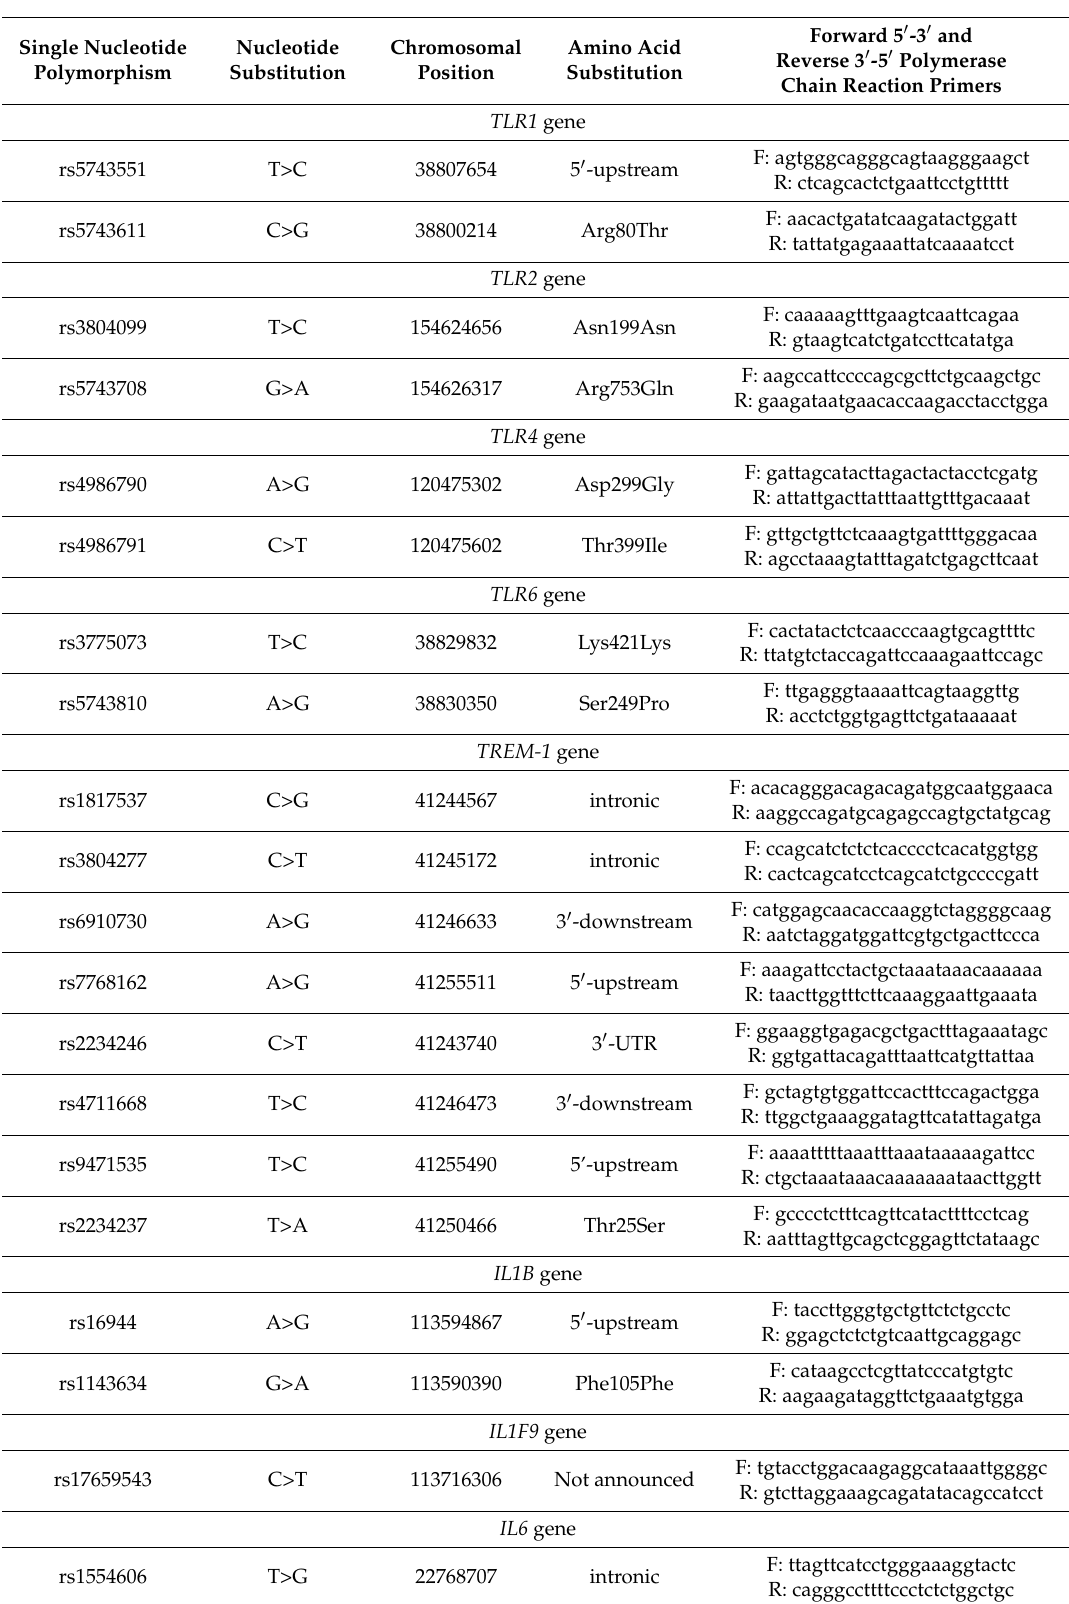
Table 5. Features of the genotyped